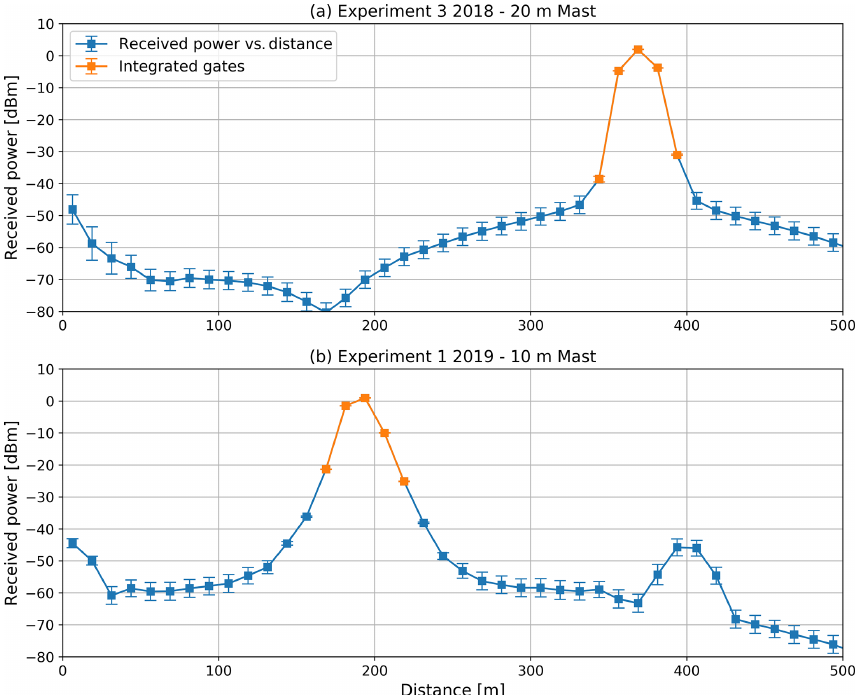
Figure 3. Mean profiles of received power for experiment 5 in 2018, using the 20m mast (a) , and experiment 1 in 2019, using the 10m mast (b) . Standard deviation at each gate is indicated with an error bar. The gates are integrated to calculate the reference reflector, and the backscattered power P r (r 0 ) is marked in orange. The secondary peak of panel (b) , around 400m, corresponds to reflections on trees behind the 10m